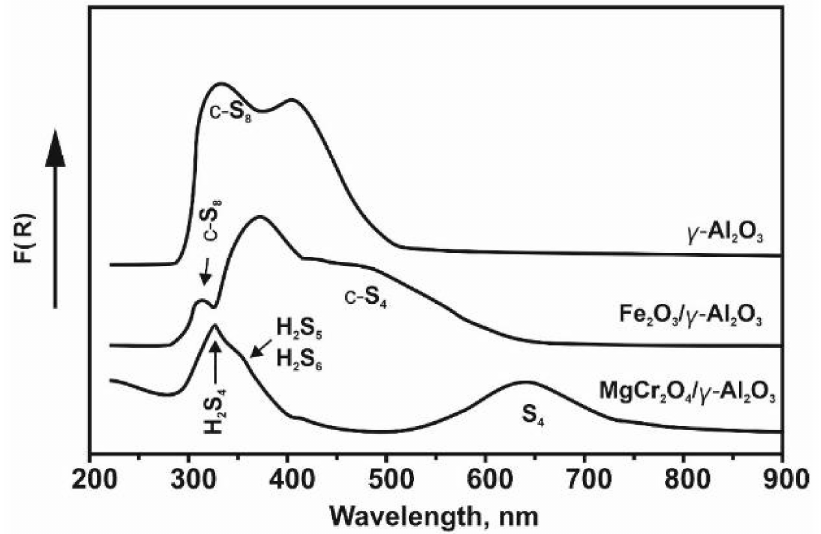
Figure 12. Different sulfur species formed on the surface of catalysts after H 2 S oxidation, as detected by UV DRS (30 torr H 2 S, 1 h, T = 250 ◦